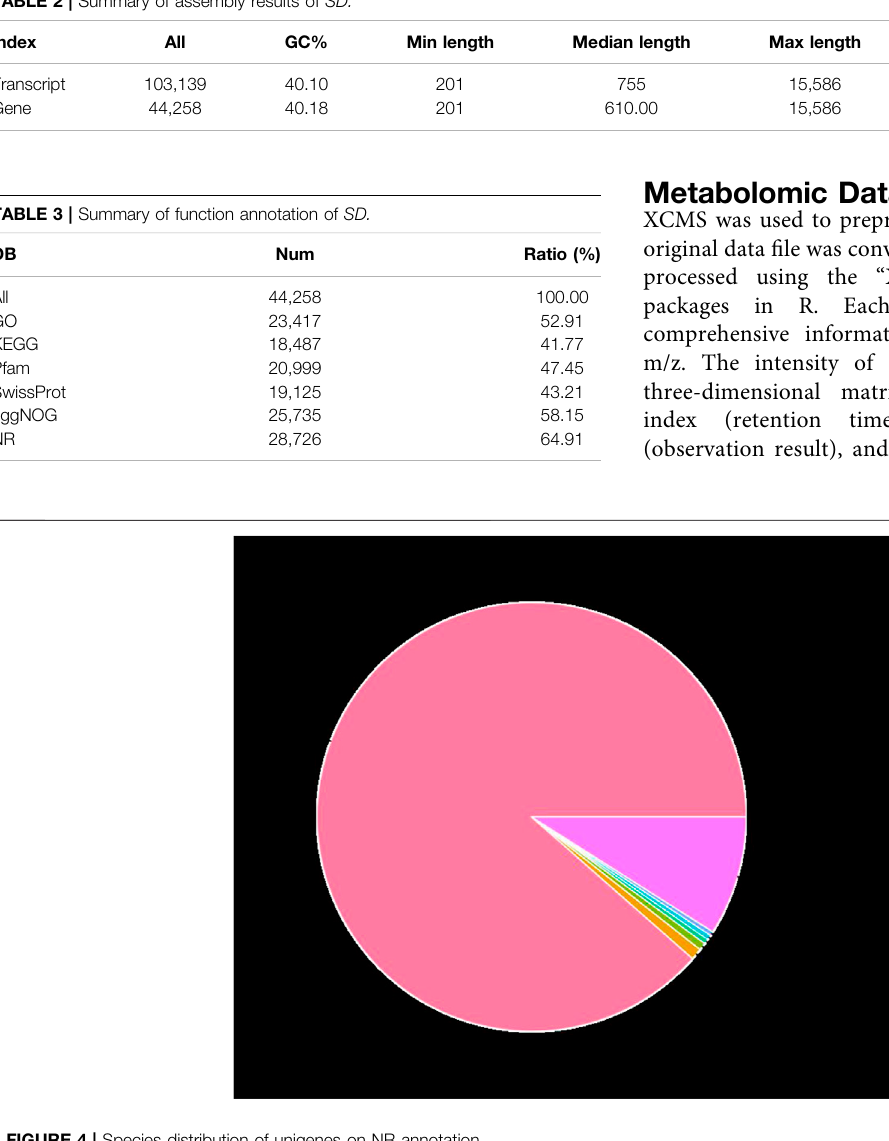
FIGURE 4 | Species distribution of unigenes on NR